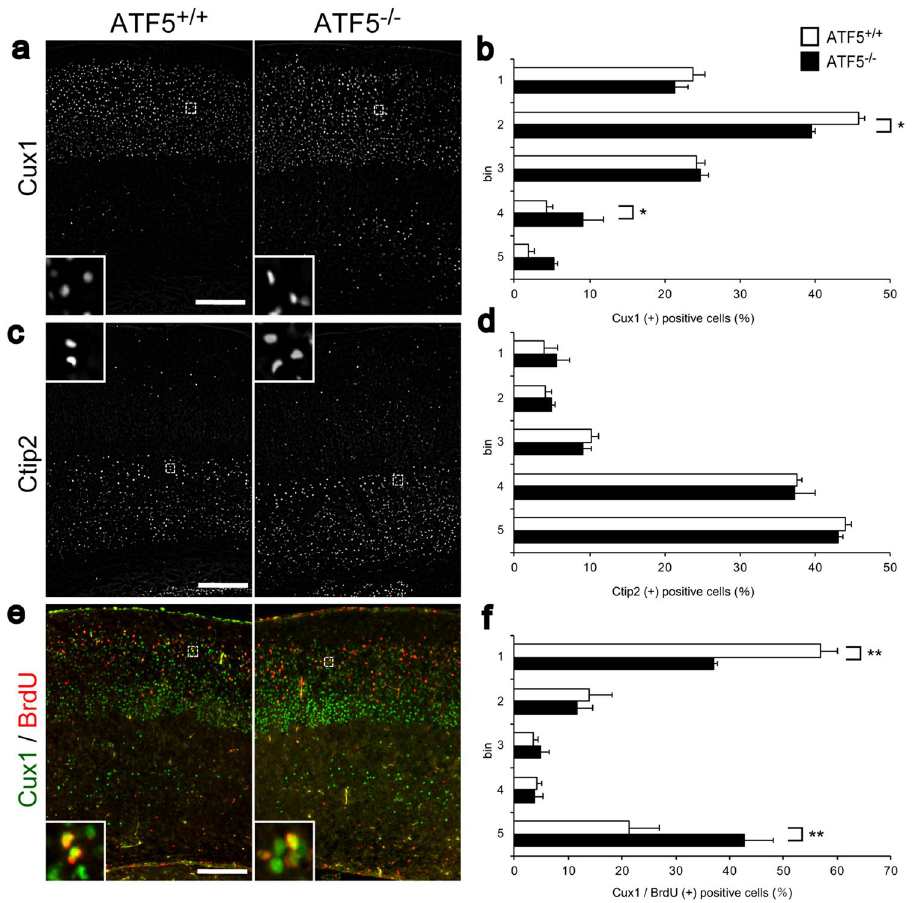
Figure 8. ATF5 deficiency impaired the localization of upper cortical layer neurons in the ATF5 −/− cortex. ( a – d ) Immunostaining for Cux1, an upper cortical layer neuron marker (layer II–VI) ( a ), and Ctip2, a lower cortical layer neuron marker (layer V/IV) ( c ), in cortical sections on postnatal day 21 (P21). ( e ) Immunostaining for BrdU and Cux1 in P7 cortical sections of offspring from mice that were injected intraperitoneally with BrdU on embryonic day 16 (E16; 200 mg/kg maternal body weight) and dissected on P7. ( b , d , f ) Quantification of the percentages of Cux1-positive cells ( b ), Ctip2-positive cells ( d ), or Cux1/BrdU double-positive cells ( f ) divided equally into five bins of the cortex. Each inset shows an enlarged view of the dotted line box. Data are presented as mean ± S.E.M. ( n = 3 mice per group, * p < 0.05, ** p < 0.01; two-way ANOVA followed by Tukey HSD test). Scale bars represent 200